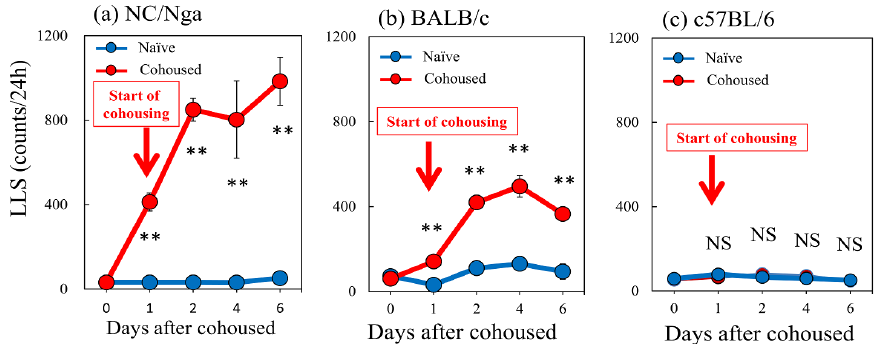
Figure 4. Time-course changes in long-lasting scratching (LLS) counts caused by mite infestation between NC/Nga, BALB/c, and C57BL/6 mice. ( a ) Mite infestation increased LLS counts in SPF- NC/Nga mice. ( b ) Mite infestation increased LLS counts in BALB/c mice. ( c ) In C57BL/6 mice, no significant changes in LLS counts were observed. Blue line indicates naïve mice. Red lines indicate cohoused mite-infested mice. Red arrow indicates the start of cohousing with skin-lesioned NC/Nga mice. Each value represents the mean ± standard error (S.E.) from six mice (total of 36 mice). NS, not significant. ** p < 0.01 when compared with the respective value of naïve mice (Student’s t -test with Bonferroni